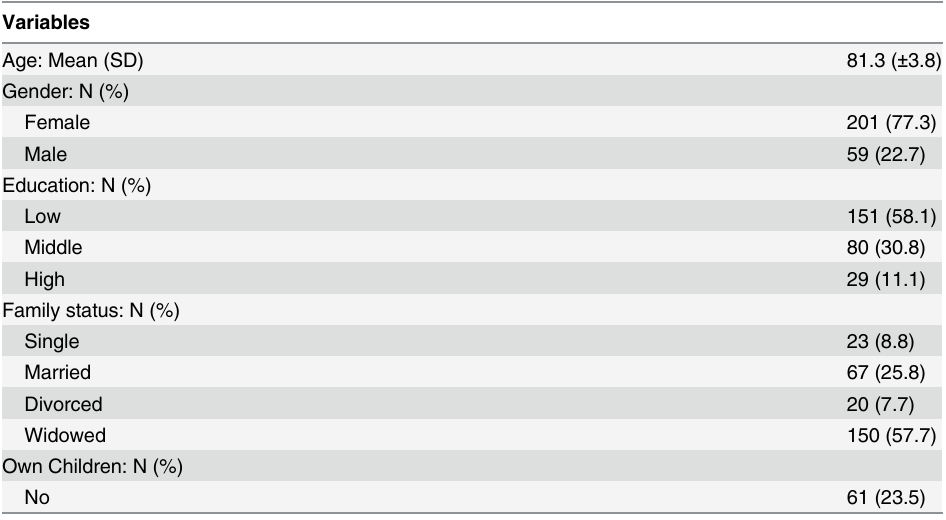
Table 1. Sample characteristics at baseline: Individuals who were institutionalized sometime after baseline (n =